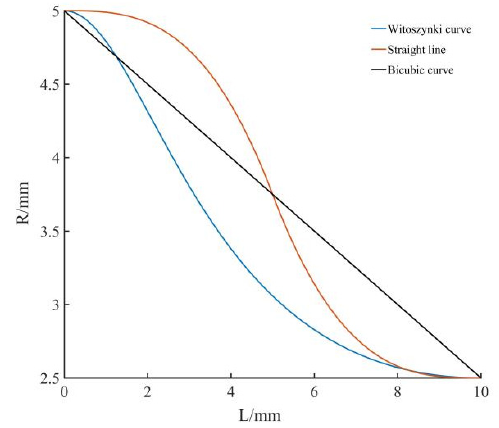
Figure 8. Three kinds of curves.